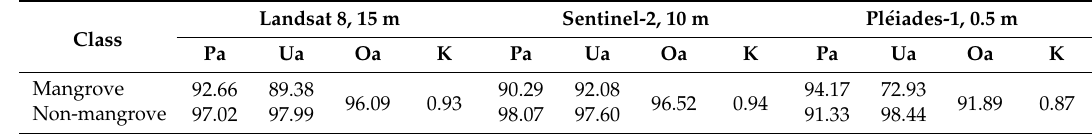
Table 7. Accuracy descriptive statistics of vegetation cover type level.